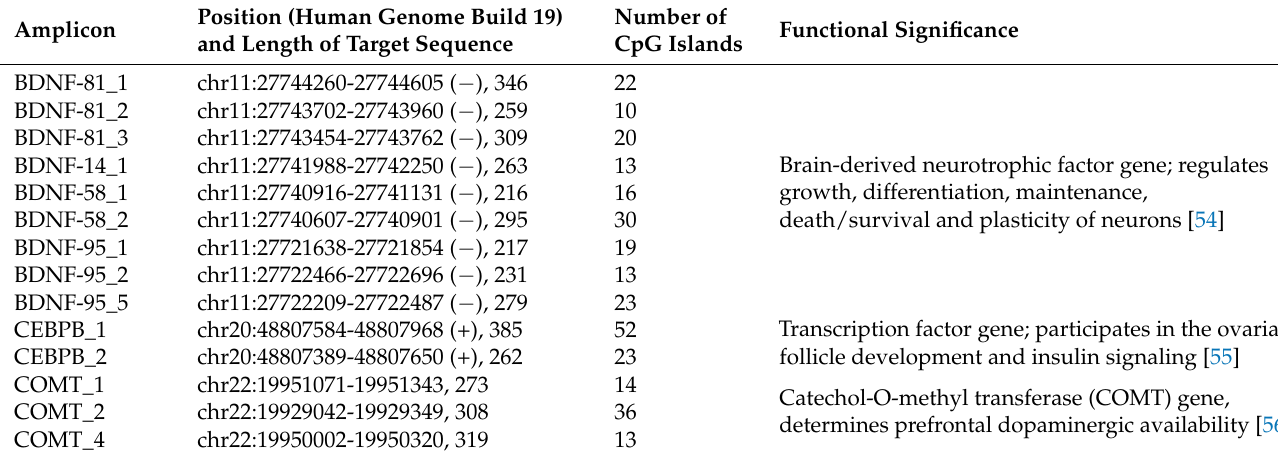
Table 2. Amplicon positions of candidate genes and their functional